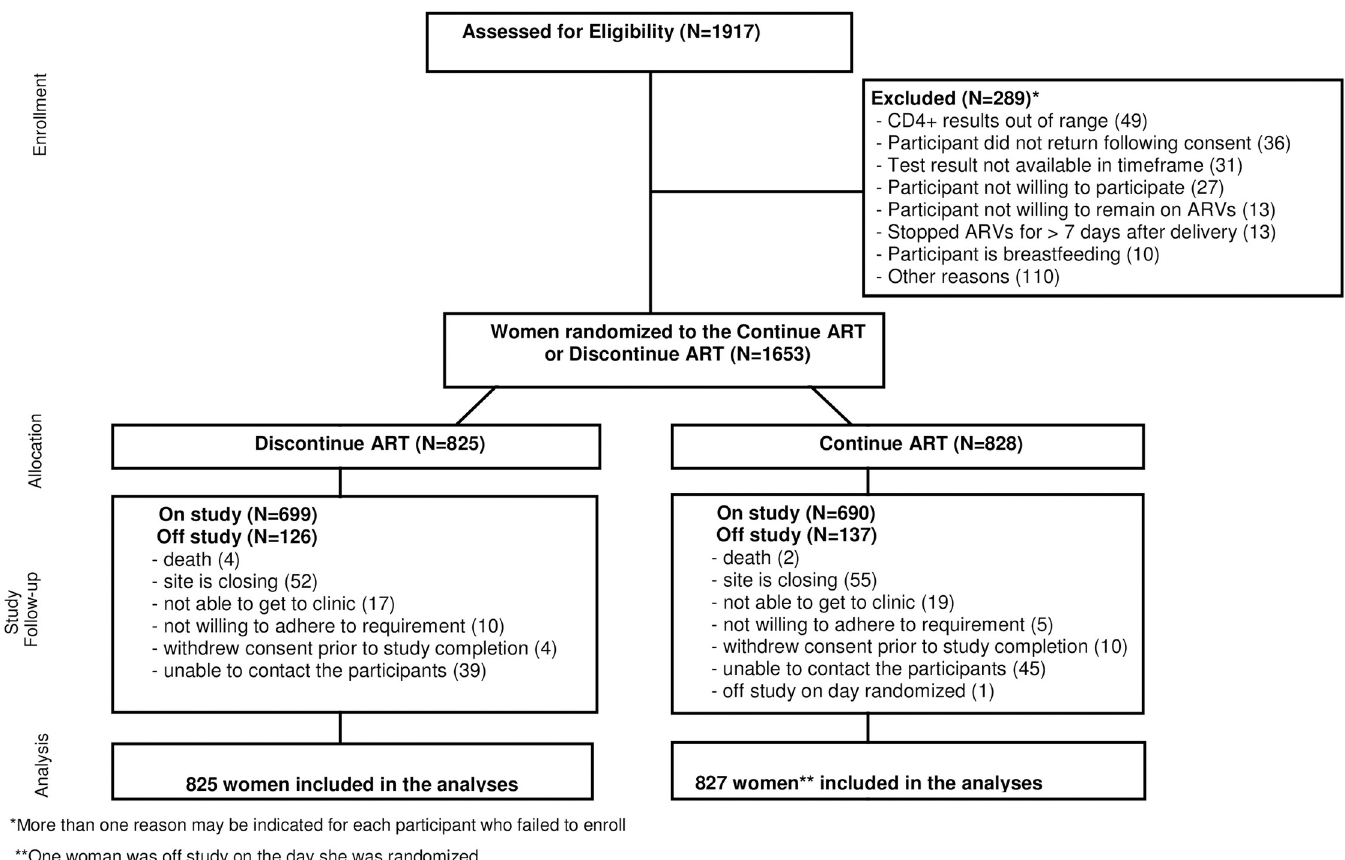
Fig 1. CONSORT Flow